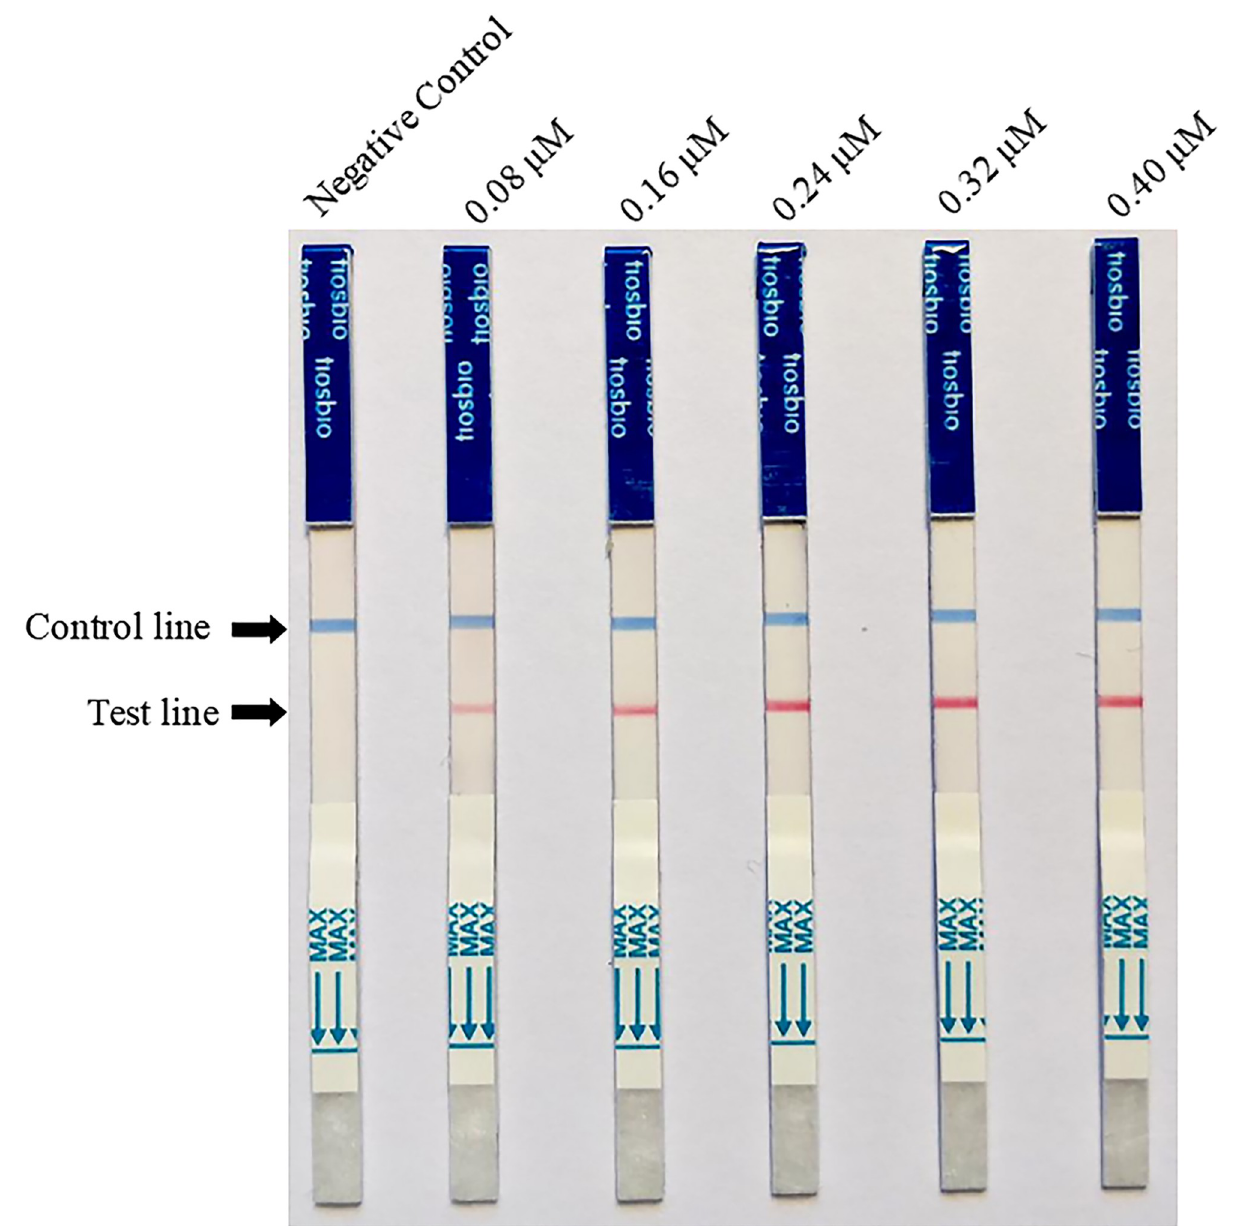
Fig 1. Optimization of primer concentration for recombinase polymerase amplification combined with lateral flow test. A darkened test line indicates a positive result.